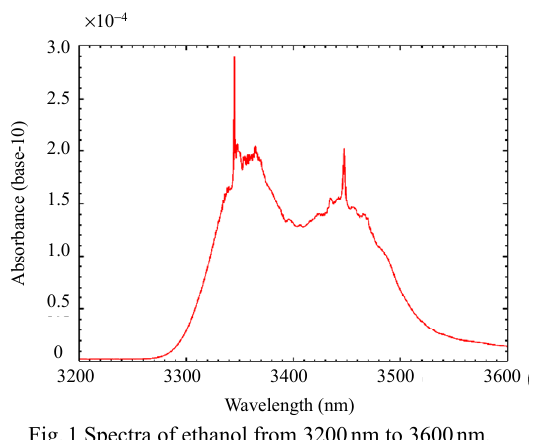
Fig. 1 Spectra of ethanol from 3200 nm to 3600 nm.